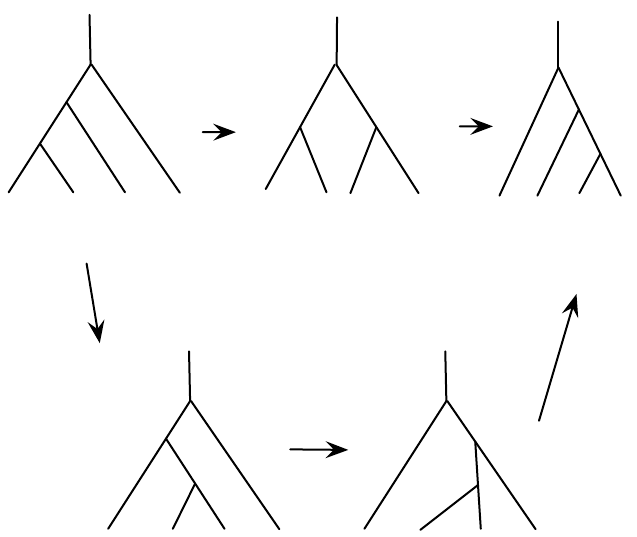
Figure 3 . The pentagon identity guarantees that two distinct ways to rearrange the order of the tensoring of four lines lead to the same result.